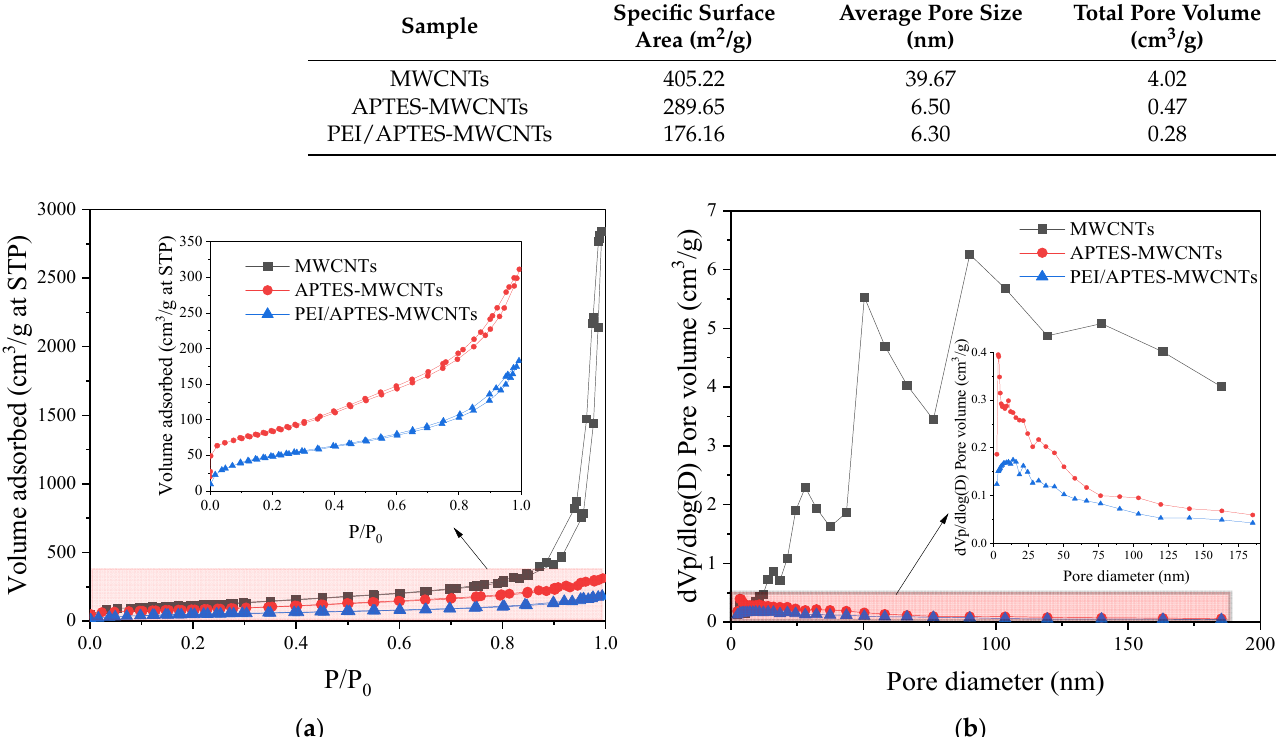
Figure 4. ( a ) N 2 adsorption–desorption isotherms and ( b ) pore size distribution of MWCNTs, APTES-MWCNTs, and PEI/APTES-MWCNTs.